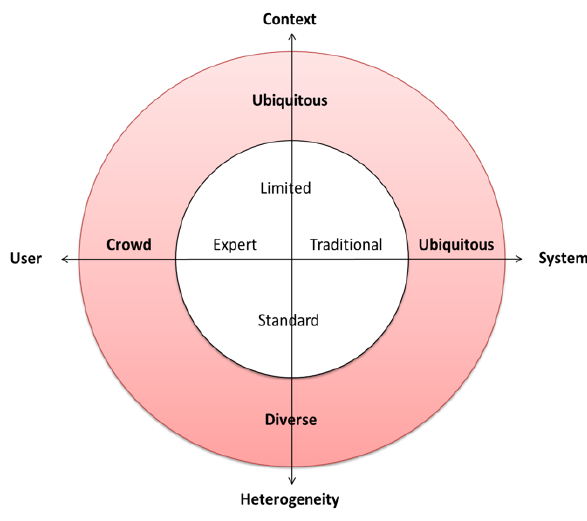
Figure 1. Research Dimensions